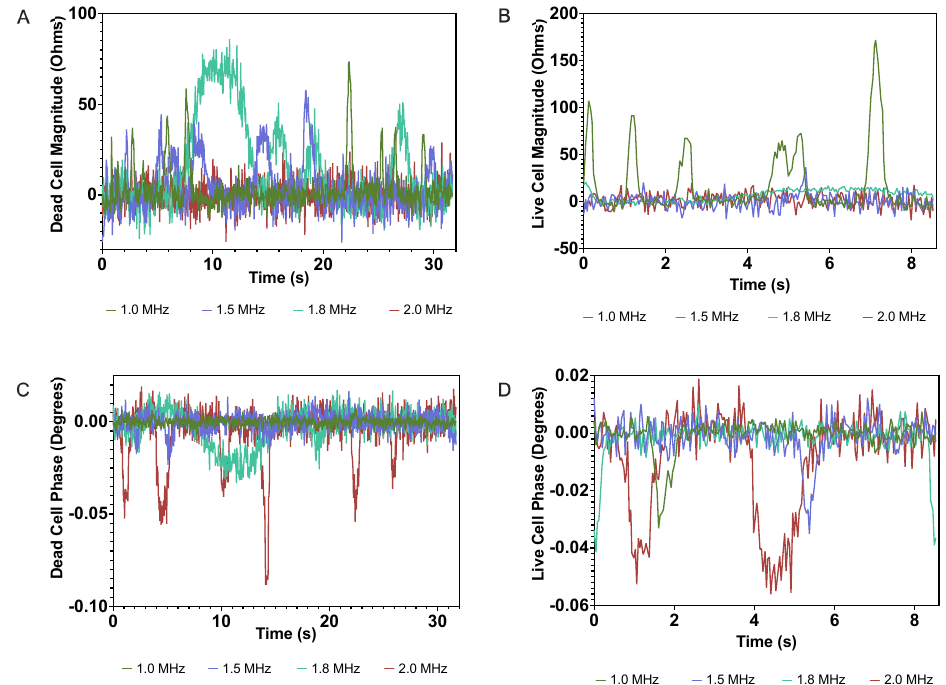
Figure 4. Relative impedance magnitude changes of ( A ) dead and ( B ) live cells at 1.0, 1.5, and 2 MHz interrogation frequencies. Relative impedance phase changes of ( C ) dead and ( D ) live